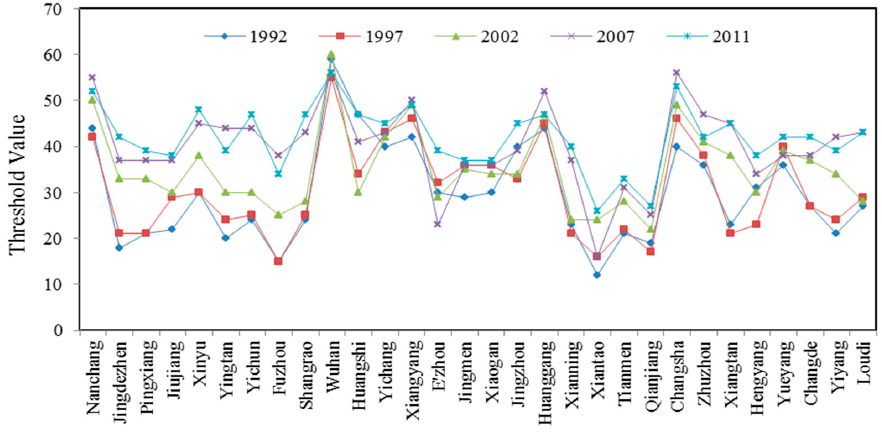
Figure 4. Optimal threshold value used to extract urban extents for 30 cities in MRYR in different years.